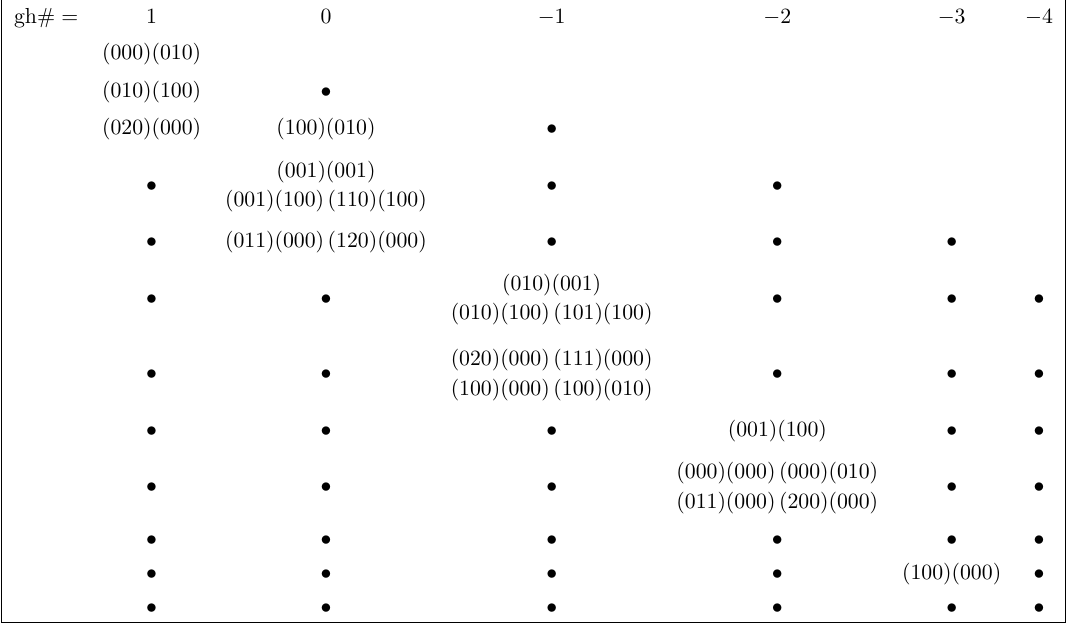
Table 2 . The zero-mode cohomology for the N = (3 , 0) gravity